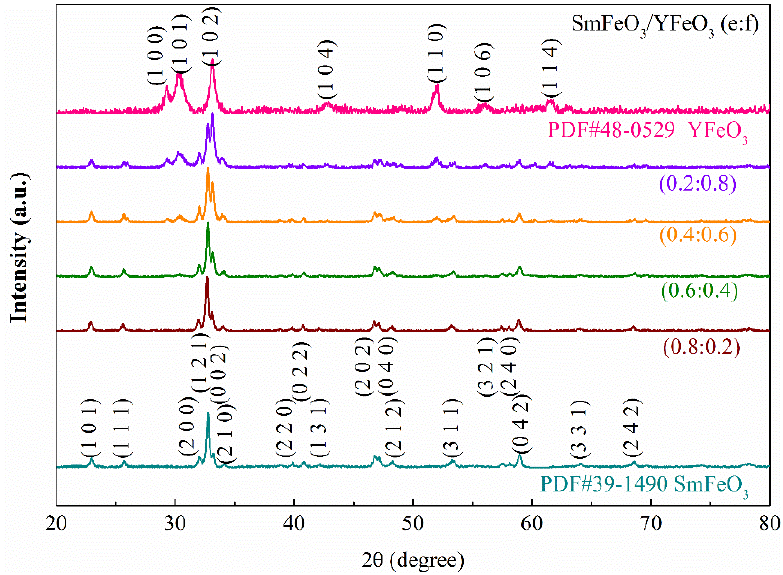
Figure 1. The X- ray diffraction patterns of SmFeO 3 /YFeO 3 (e:f) powder nanomaterials. Figure 1. The X-ray diffraction patterns of SmFeO